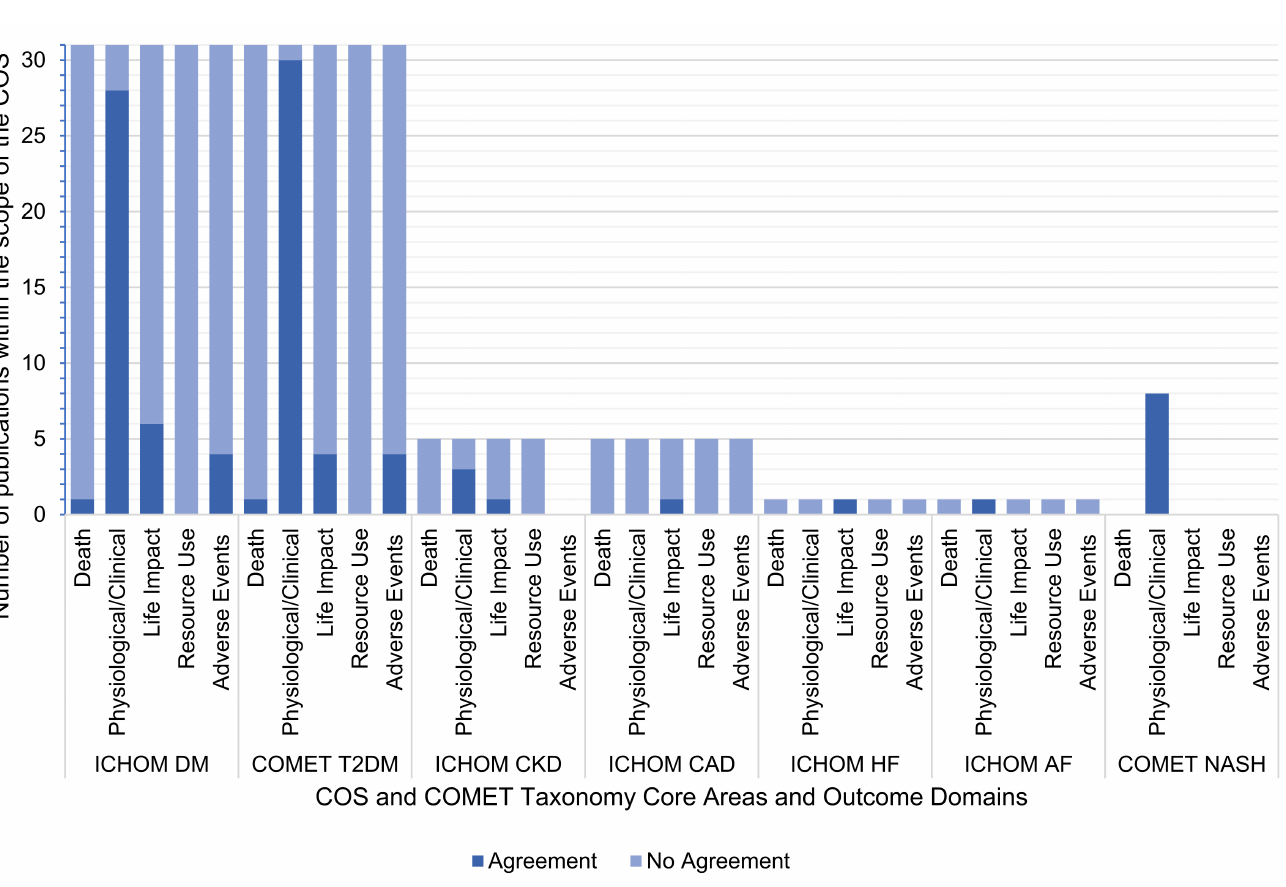
Figure 5. Agreement between outcomes reported by RCTs and their relevant COS, classified according to COMET taxonomy core areas. Note: Outcomes were in agreement when one or more comparable outcome was evaluated by both the RCT and the applicable COS. Some RCTs had more than one COS applicable to them, so they are included under both COS.